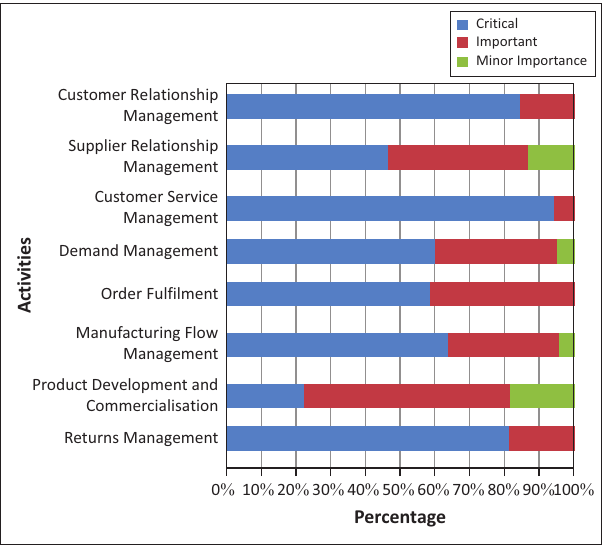
FIGURE 1: Importance ascribed to the activities within each strategic supply chain management process.